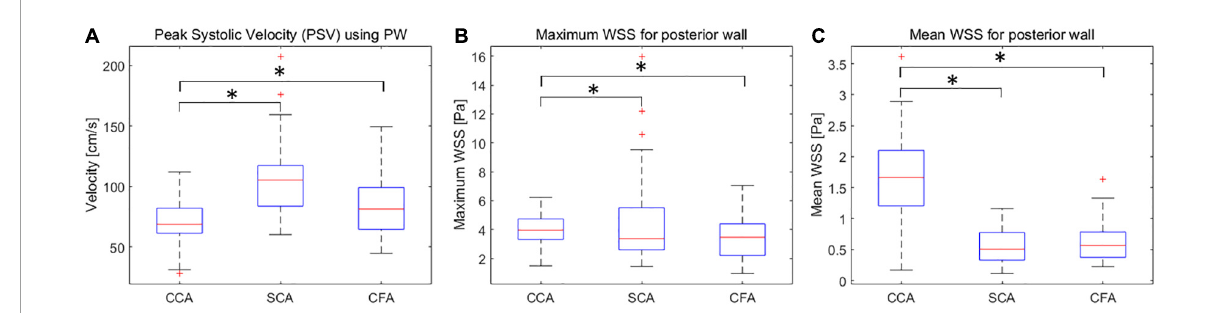
FIGURE2 Box plots of PSV (A) , wall shear stress (WSS) maxima (B) and means (C) for CCA, SCA, and CFA in healthy adult volunteers (vertical axis) corresponding to different peripheral artery locations (horizontal axis). CCA, common carotid artery; SCA, subclavian artery; CFA, common femoral artery. * P < 0.05.